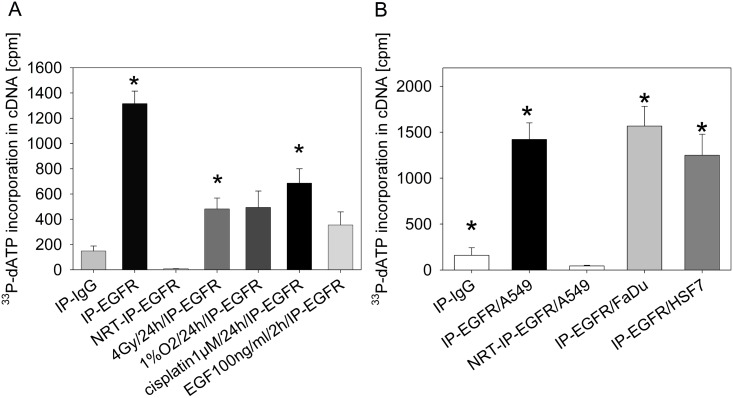
Detection of cDNAs synthesized from mRNAs enriched in complexes containing nuclear EGFR after exposure to different treatments in the presence of 33P-dATP.A: A549 cells were treated as indicated and EGFR was immunoprecipitated from the nuclear protein fraction (n = 3). The mRNAs that were bound to EGFR were reverse transcribed into cDNAs in the presence of 33P-dATP without amplification. Labeled cDNAs were isolated by gel filtration and the incorporated radioactivity was quantified using a scintillation counter. The detected radioactivity was normalized to nEGFR protein concentrations (S2A Fig). NRT = NRT control; we performed a mock reverse transcription reaction containing IP-EGFR and all RT-PCR reagents, with the exception of the reverse transcriptase. We performed a two-sample t-test combined with Bonferroni’s correction; *p < 0.008 compared to NRT-IP-EGFR. B: EGFR was immunoprecipitated from tumor cell lysates (A549 and FaDu) and normal skin fibroblast (HSF7) lysates. We performed a two-sample t-test combined with Bonferroni’s correction; *p < 0.01 compared to NRT-IP-EGFR/A549. Precipitates were used for reverse transcription in the presence of 33P-dATP. RNA was isolated by column chromatography and the amount of labelled mRNA was quantified using a scintillation counter. The incorporated radioactivity was normalized to nuclear EGFR protein concentrations (S2B Fig).